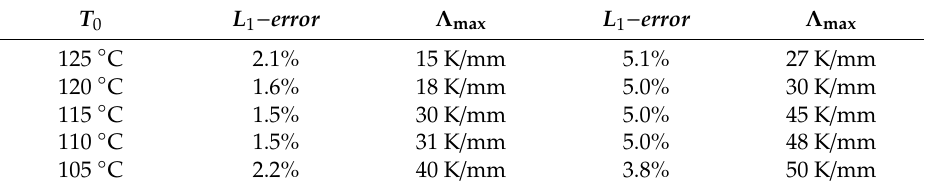
Table 1. Maximum temperature gradient under di ff erent central temperature.